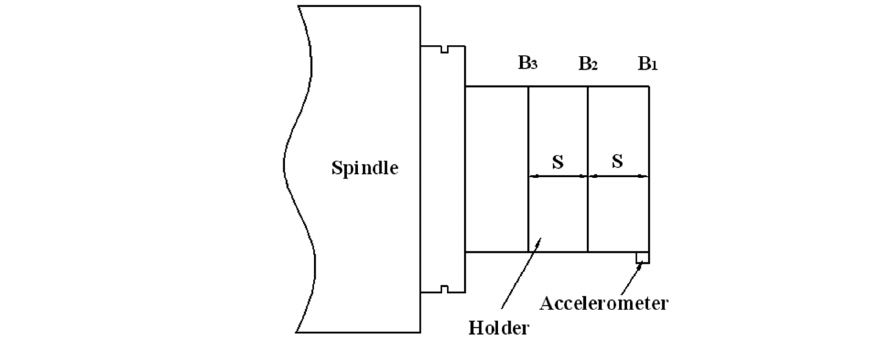
Fig. 3. Receptance identi fi cation of the spindle